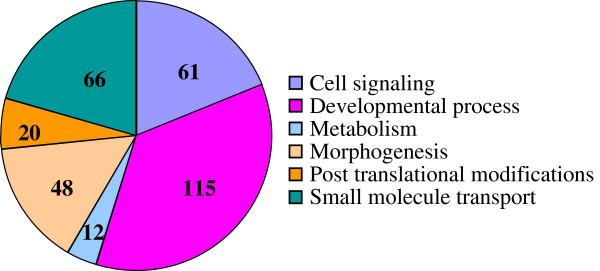
Piechart diagram showing distribution of over-expressed uterine transcripts when an eggshell calcification is underway. Gene Ontology (GO) parent terms were used for the overall interpretation of data from microarrays. The numbers of gene products for each GO parent terms are indicated into the diagram.